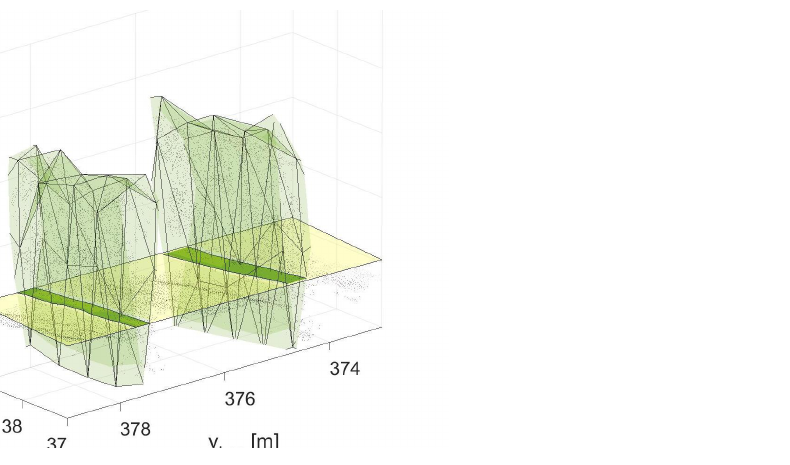
Figure 2. Example of roto-translated approximating plane (yellow plane), intersecting the 3D LCG map and generating a 2D slice (green